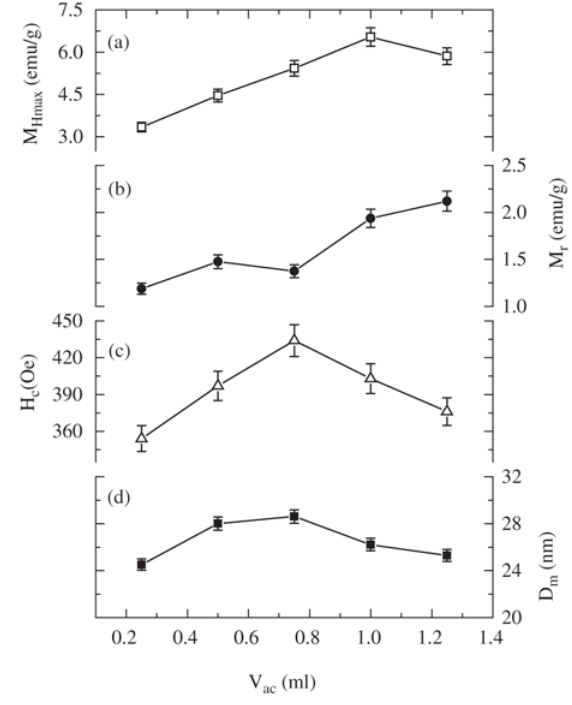
Figure 5. Magnetic properties of Fe nitric acid concentrations: a) Maximum field magnetization; b) Remanent magnetization; c) Coercive field; d) Fe means particle diameter obtained of X-ray diffraction.